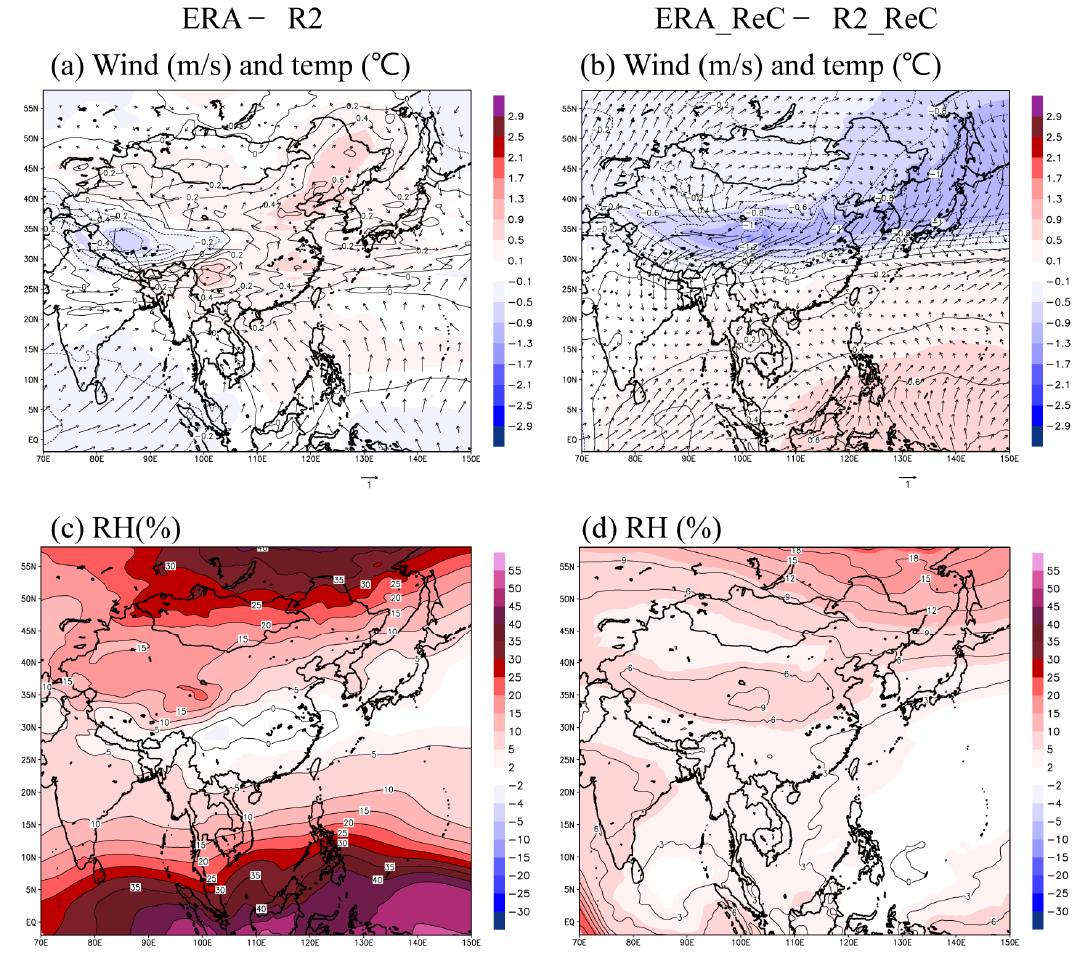
Figure 5. Spatial distribution of 20-year summer mean differences for ( a , b ) wind field (m/s) and temperature (°C); ( c , d ) relative humidity (RH, %); and ( e , f ) mixing ratio (Q, g/kg) at 300 hPa between the two BCs (ERA, R2) ( left ) and between the two simulations (ERA_ReC, R2_ReC) forced by the ERA and R2 datasets ( right